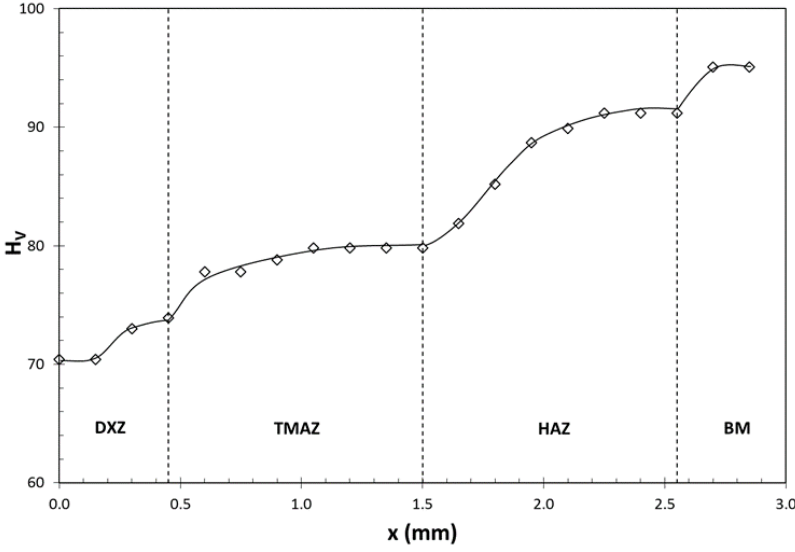
Figure 8. Microhardness profile of 6061 ‐ T6 extrusion as a function of distance from the tool edge.